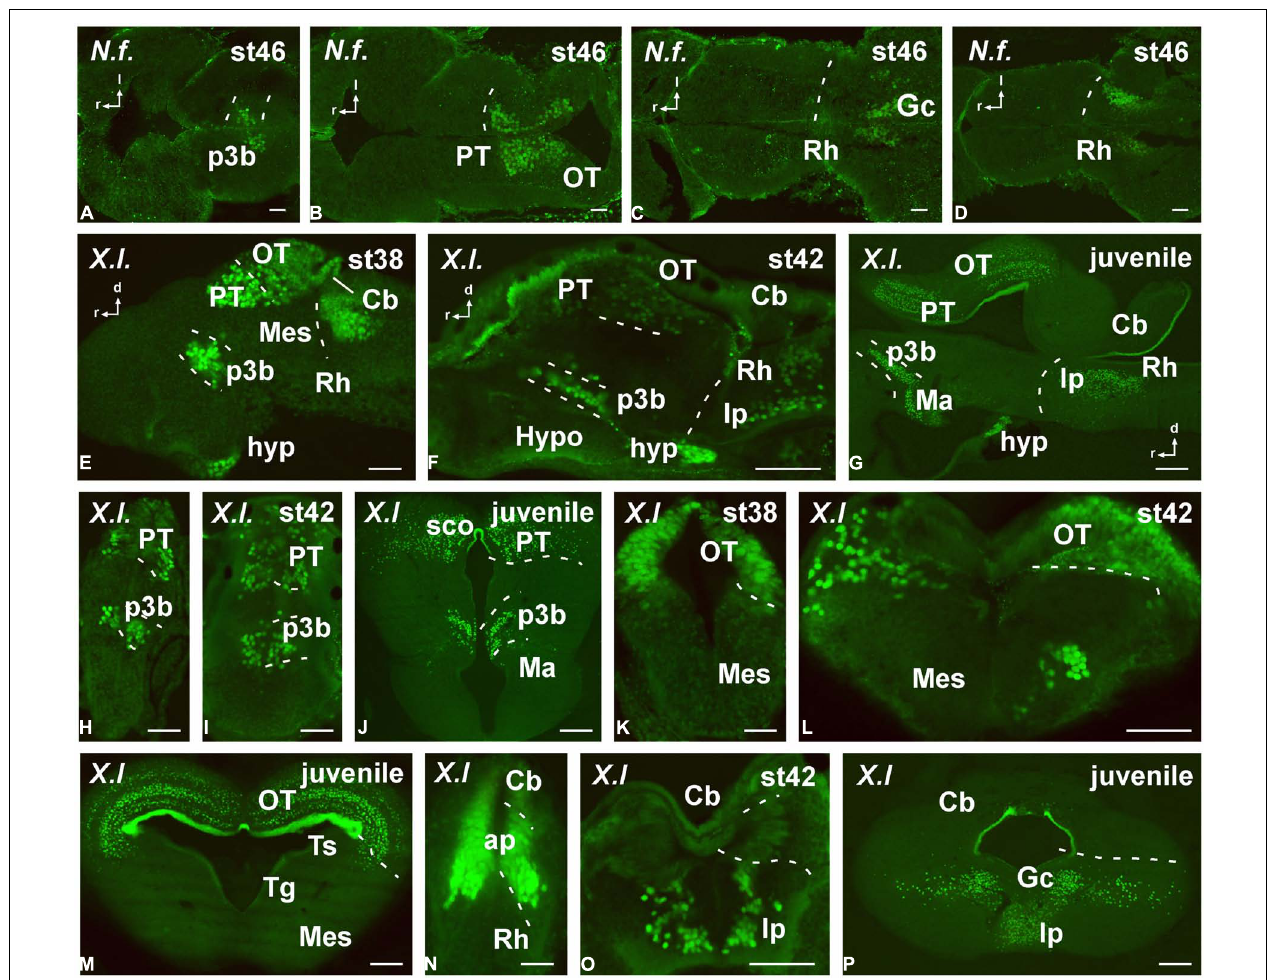
FIGURE 7 | Photomicrographs of horizontal (A–D), transverse (H–P) and sagittal (E–G) sections that serve to illustrate the localization of Pax7-immunoreactive cells in the developing brain of the anamniotes Neoceratodus forsteri (A–D) and Xenopus laevis (E–P). The conspicuous labeling in the diencephalic p3 region is illustrated at